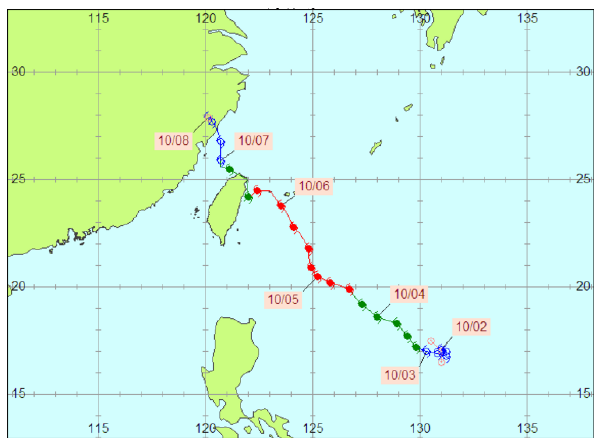
Fig. 1. Track of Typhoon Krosa (Central Weather Bureau (CWB), Taiwan). The track of Typhoon Krosa is shown in Fig. 1, with zoom in in Fig. 2. Three wave buoys were deployed in a relatively close proximity. The Guishandao Buoy was positioned in the depth of 38 h m = between a small isle of Guishandao (Turtle Island) and the northeast tip of Taiwan and is indicated by the top cross symbol in Fig 2. This is the buoy which recorded the maximal waves. Two other buoys were located further south, 25km south of the Guishandao Buoy (this buoy is further called Suao Buoy) and 100km south of the Guishandao Buoy (Hualien Buoy) . The three buoys are a standard long-term deployment by the Central Weather Bureau (CWB) of